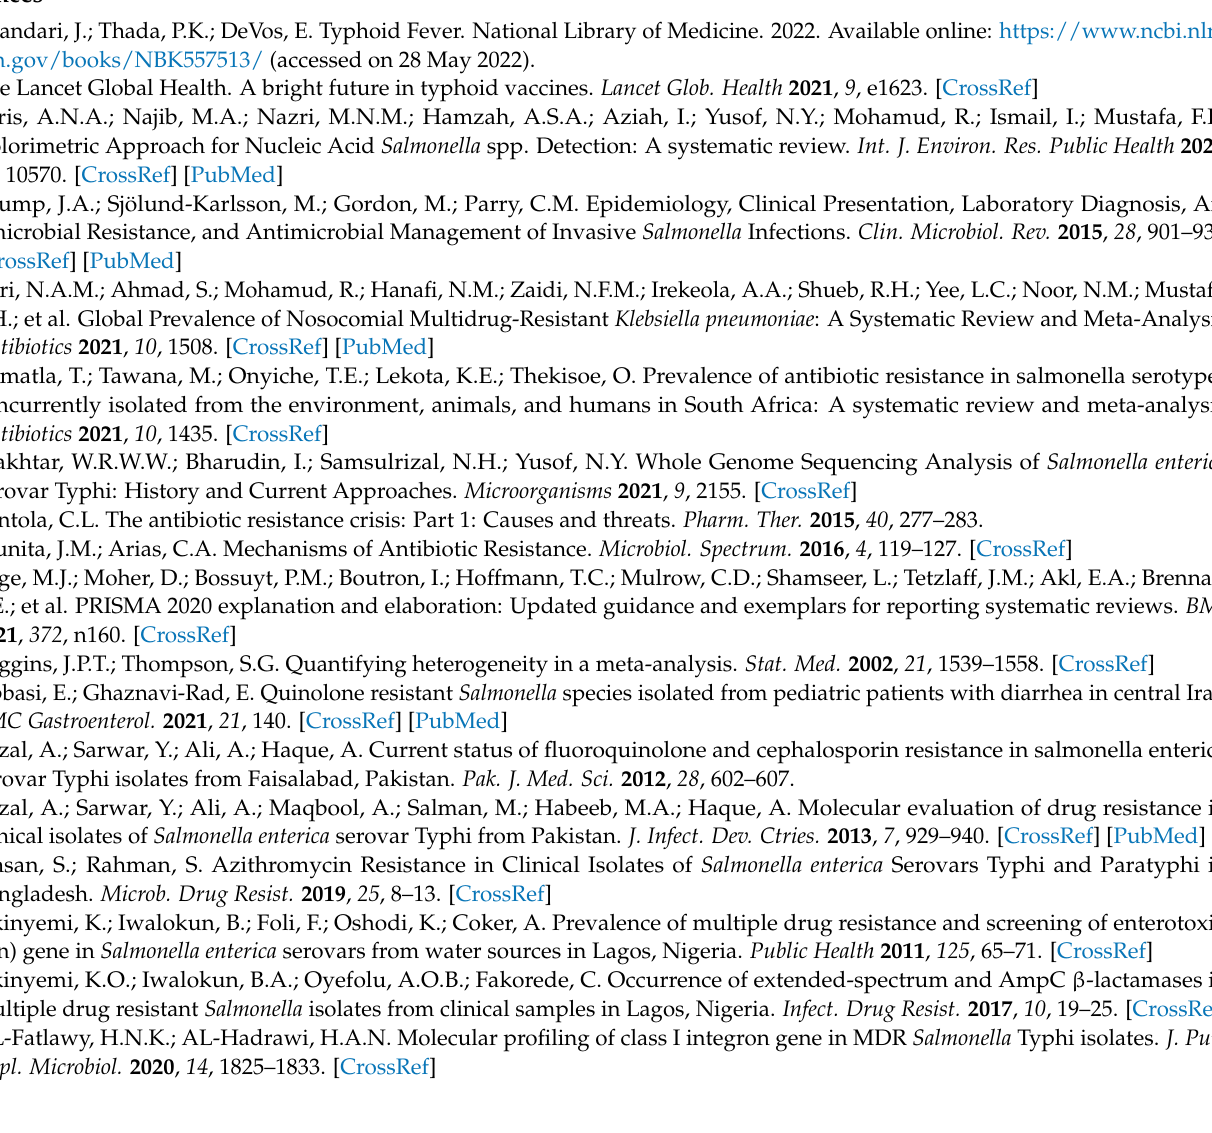
Table A2. Cont. No. Study ID (Ref.) Veeraraghavan et al., 27 2016 [50] 28 Vlieghe et al., 2012 [51] 29 Wu et al., 2010 [52] 30 Yanagi et al., 2009 [53] D87Y (8) NA NA